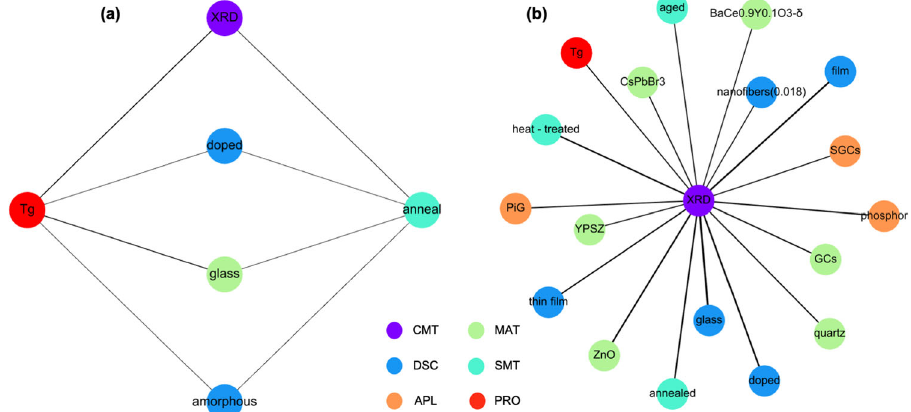
Fig. 5 Materials caption graph. a Connecting two unconnected entities, b exploring entities related to characterization method “ XRD ”